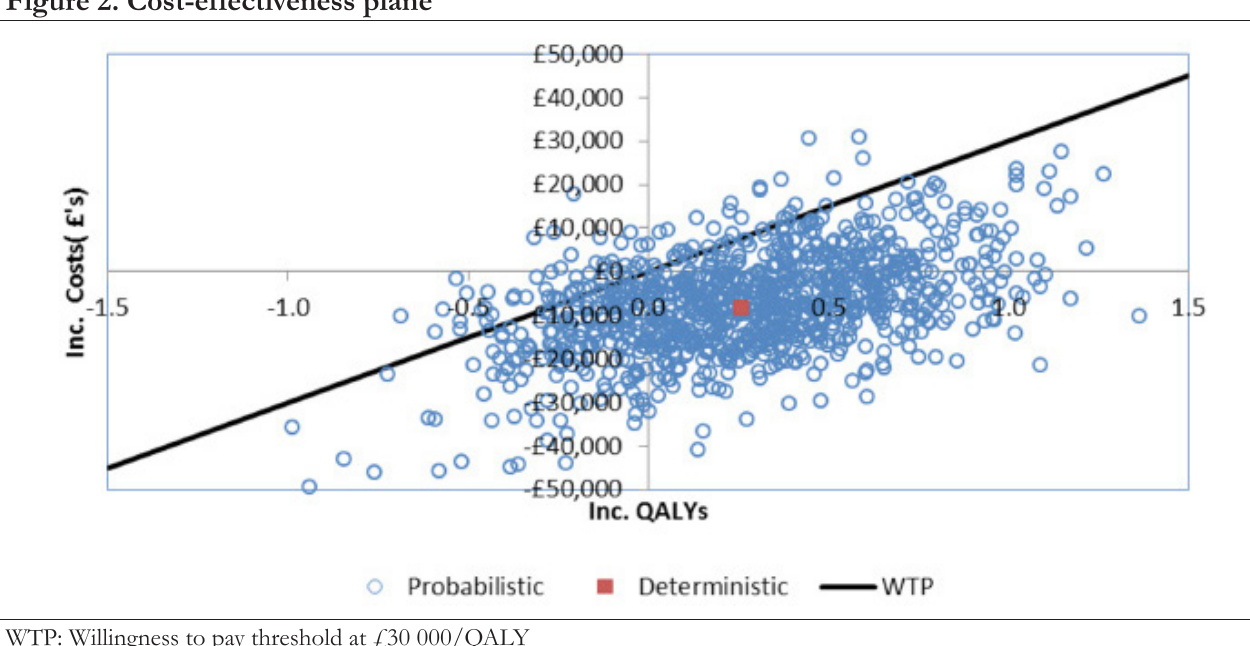
Figure 2. Cost-effectiveness